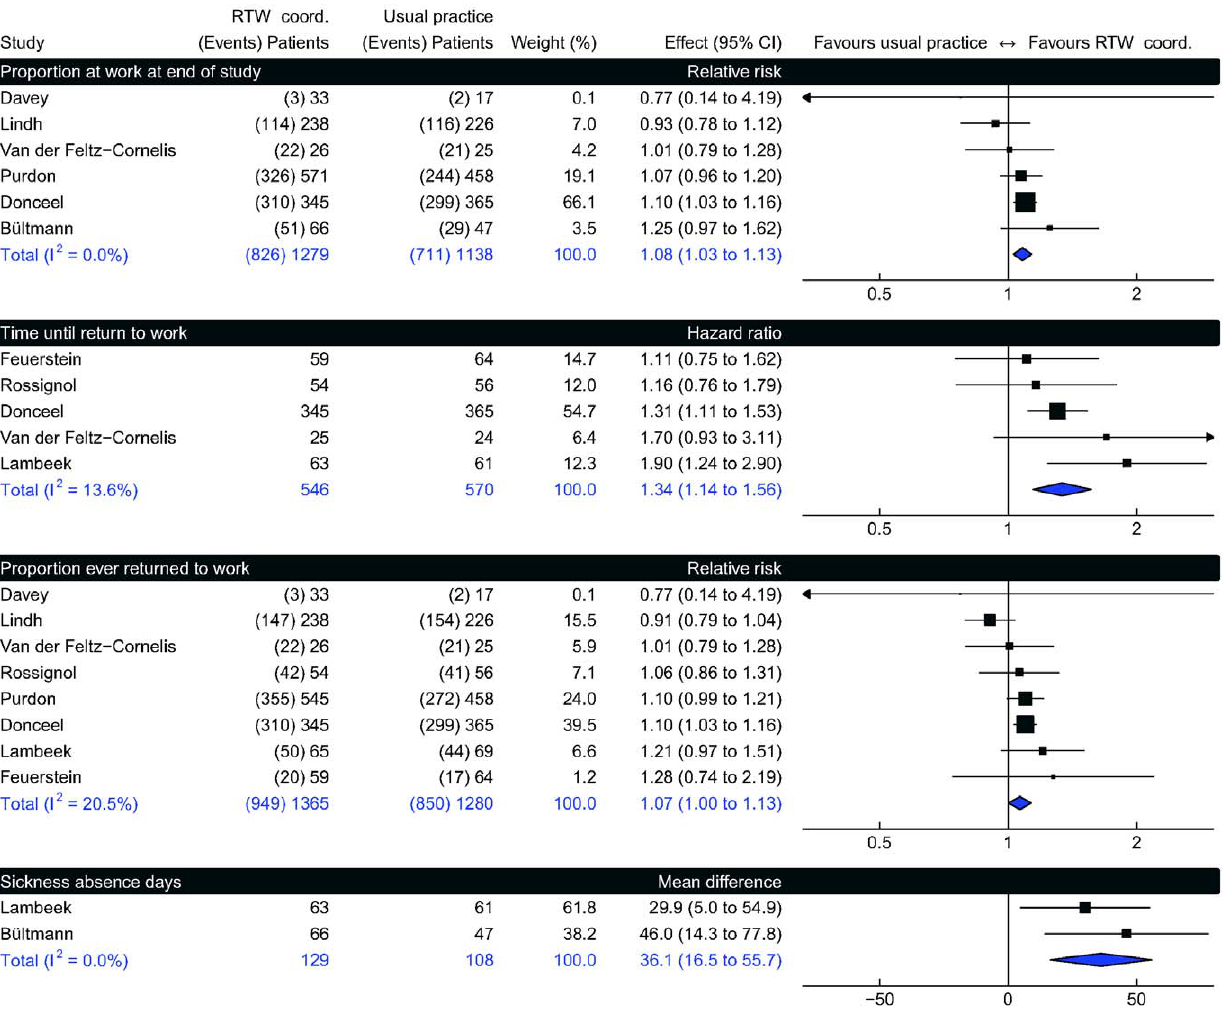
Figure 2. RTW-outcomes. RTW coord.=return to work coordination.